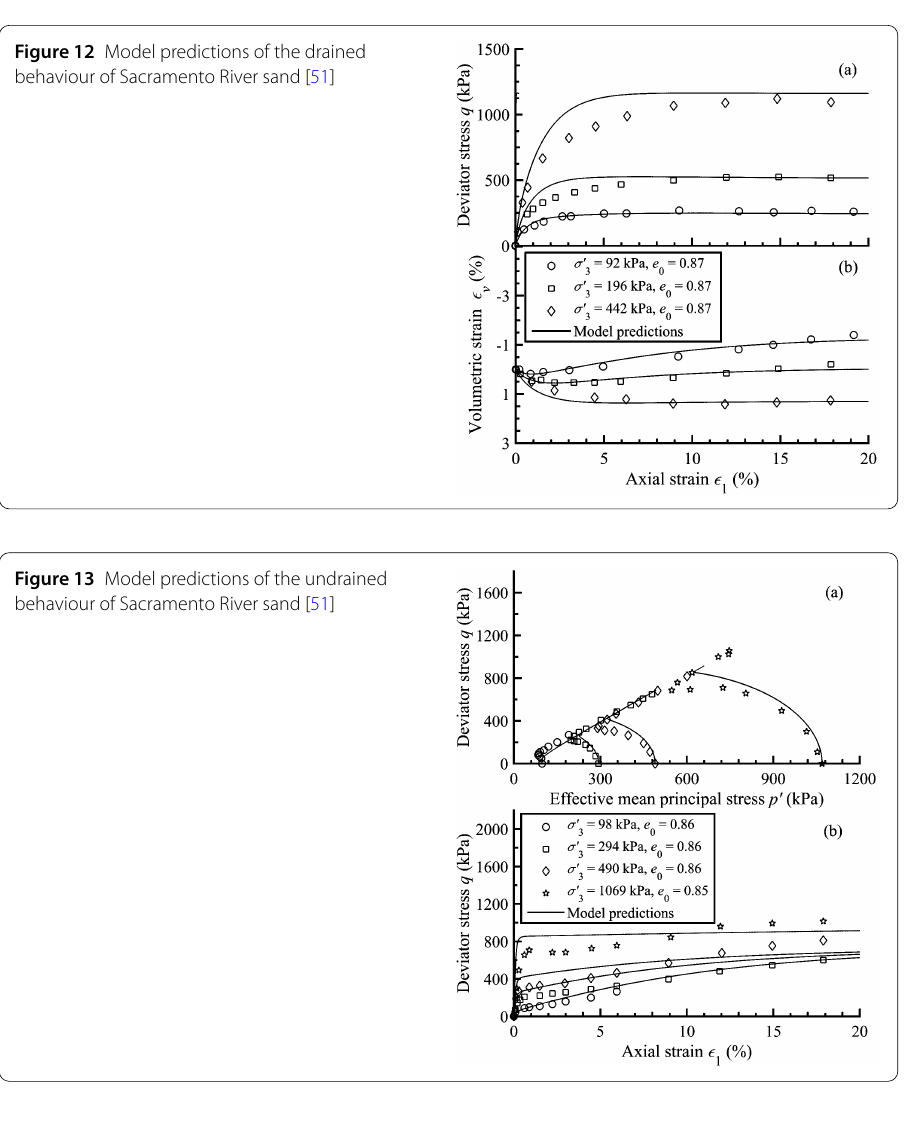
Figure 13 Model predictions of the undrained behaviour of Sacramento River sand